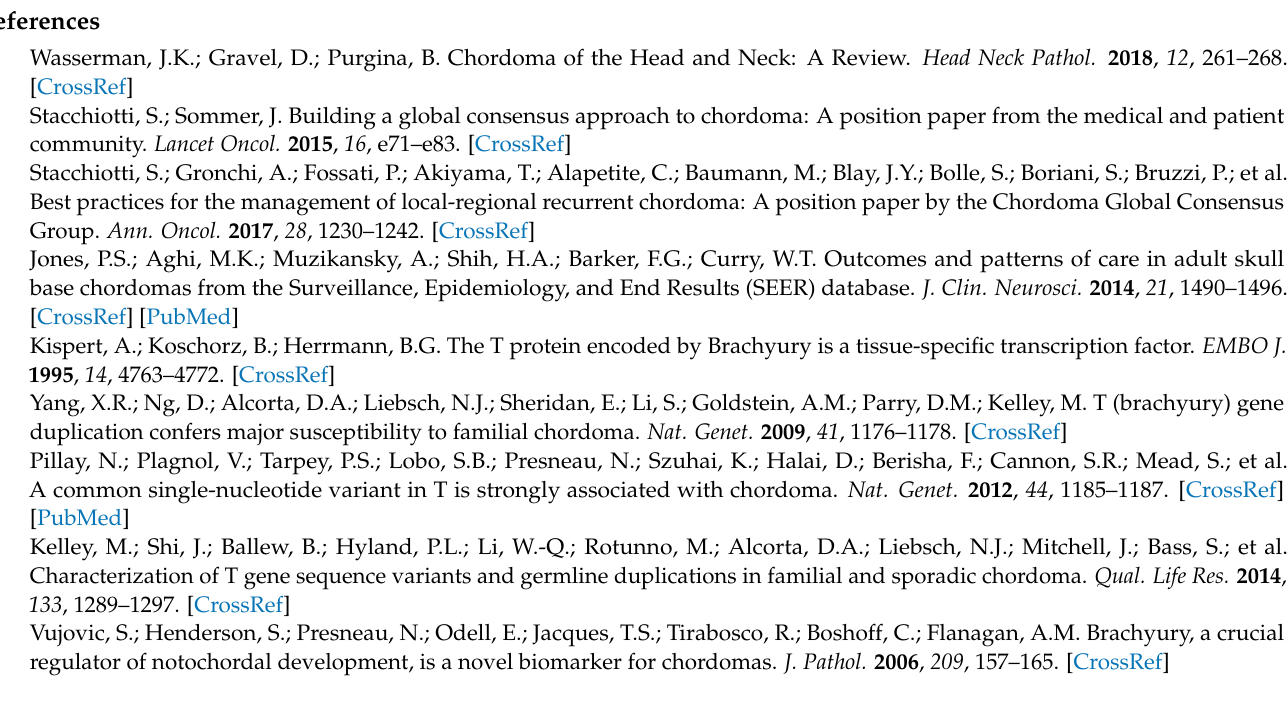
pathogenicity categories, Supplementary Table S2: Genes evaluated in this study and their bio- logical functions, Supplementary Table S3: Details of variants identified in the European ancestry dataset, Supplementary Table S4: Details of potentially pathogenic variants in the Chinese dataset, Supplementary Table S5: Top genes with higher burden of